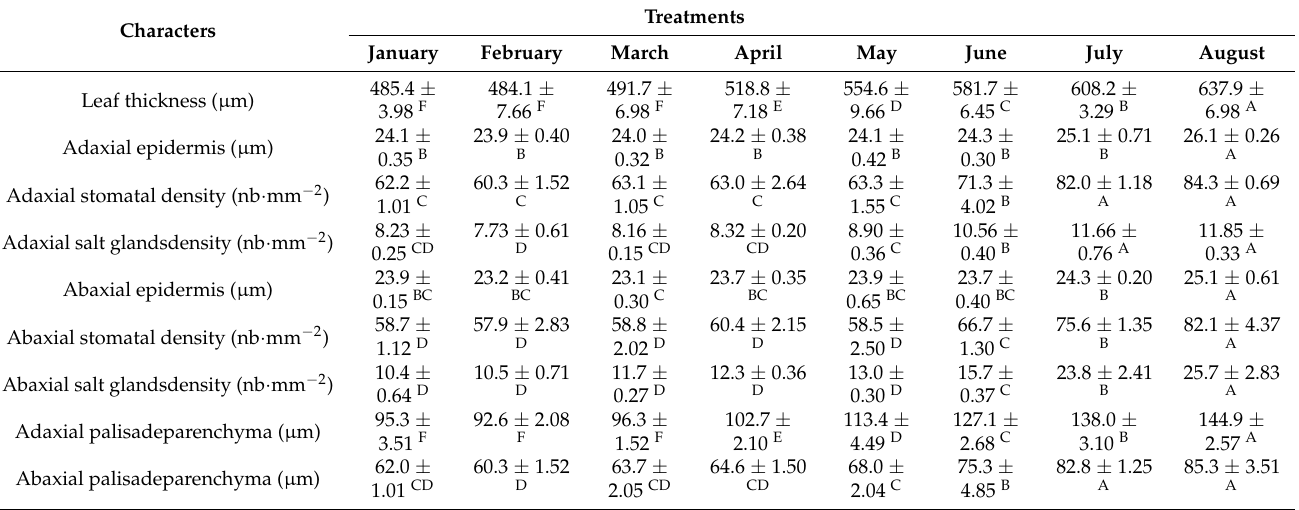
Table 1. Anatomical parameters changes in the aerial part of L. guyonianum under the variation of climatic conditions in the Sabkha of Ain Maider.